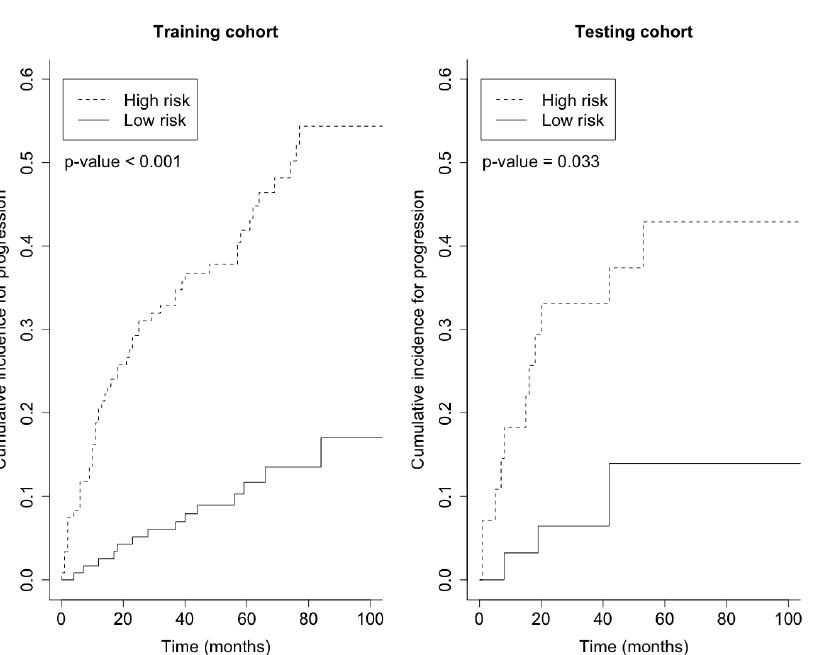
Figure 4. Cumulative incidence by risk group on the basis of the gene signature identified by the PSH-CSIS+CoxBoost